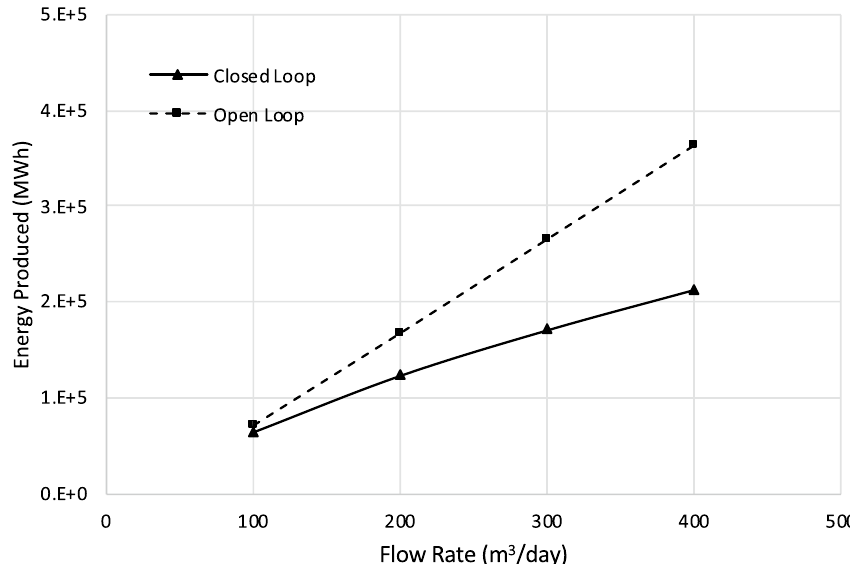
Fig. 7 Energy produced in closed and open-loop configurations (open-loop results from Chong et al.